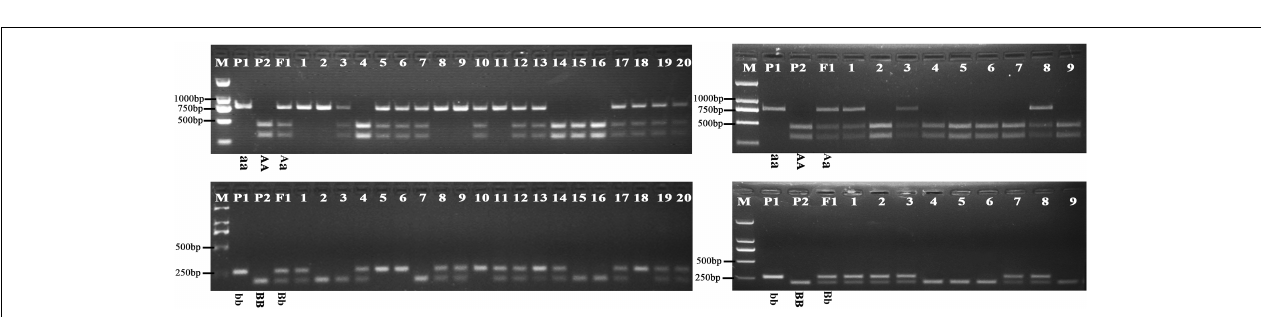
FIGURE 4 | Nucleotide trace map of the mutation site fragments in BnFAD2-1 (A) and BnFAD2-2 (B) . The upper part of the map shows the wild-type sequences, while the middle and lower parts show the hybrid type and mutation type sequences, respectively. The mutant site of each gene is indicated in a dashed frame and the numbers above the frames represent the nucleotide number when counted from the start codon ATG.